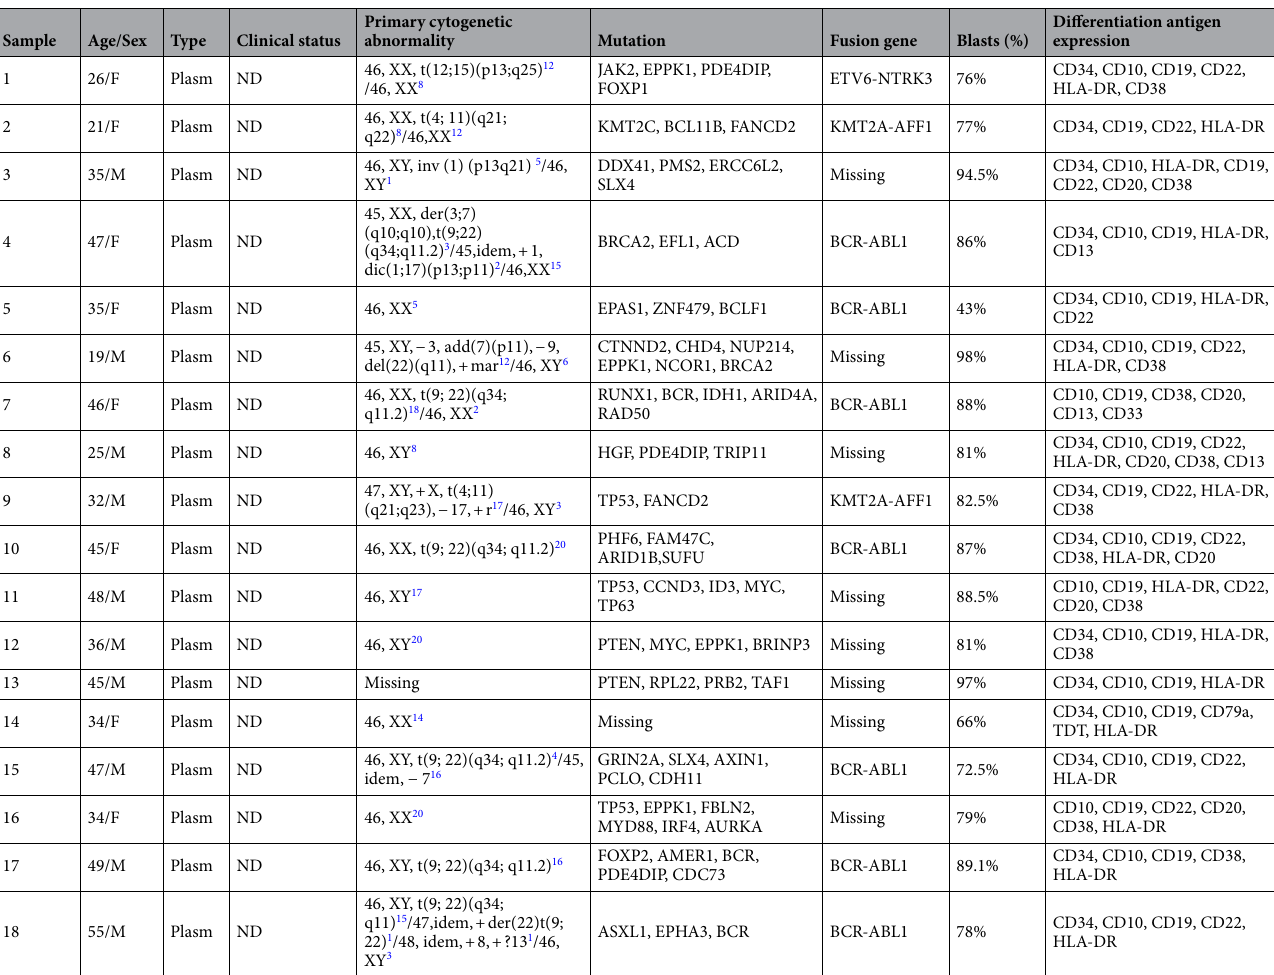
Table 1. Patients with B-ALL general information. M Male; F Female; ND Newly